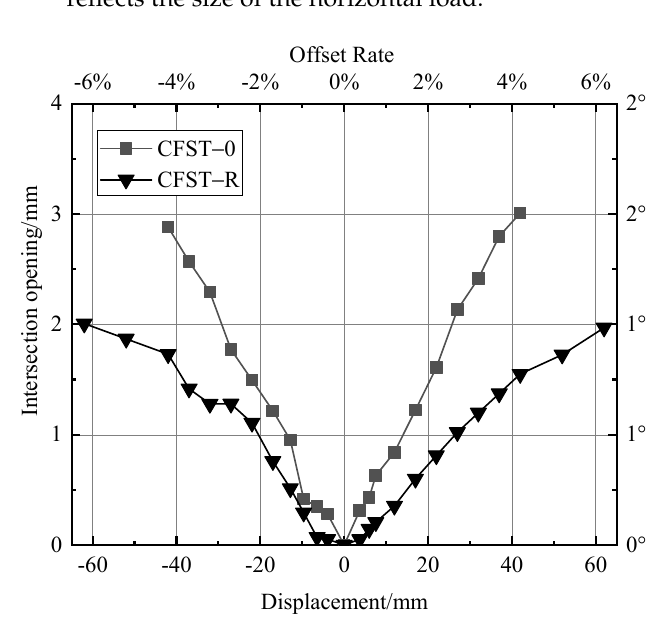
Figure 18. CFST bridge pier opening at the seam.